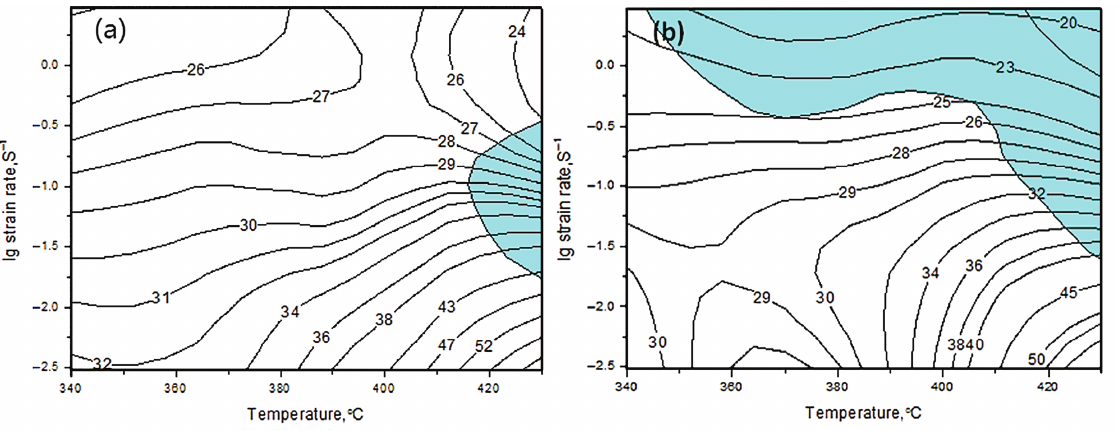
Figure 6: Processing map for different strains for AZ81E alloys: (a) ε = 0.4; (b) ε = 0.6.